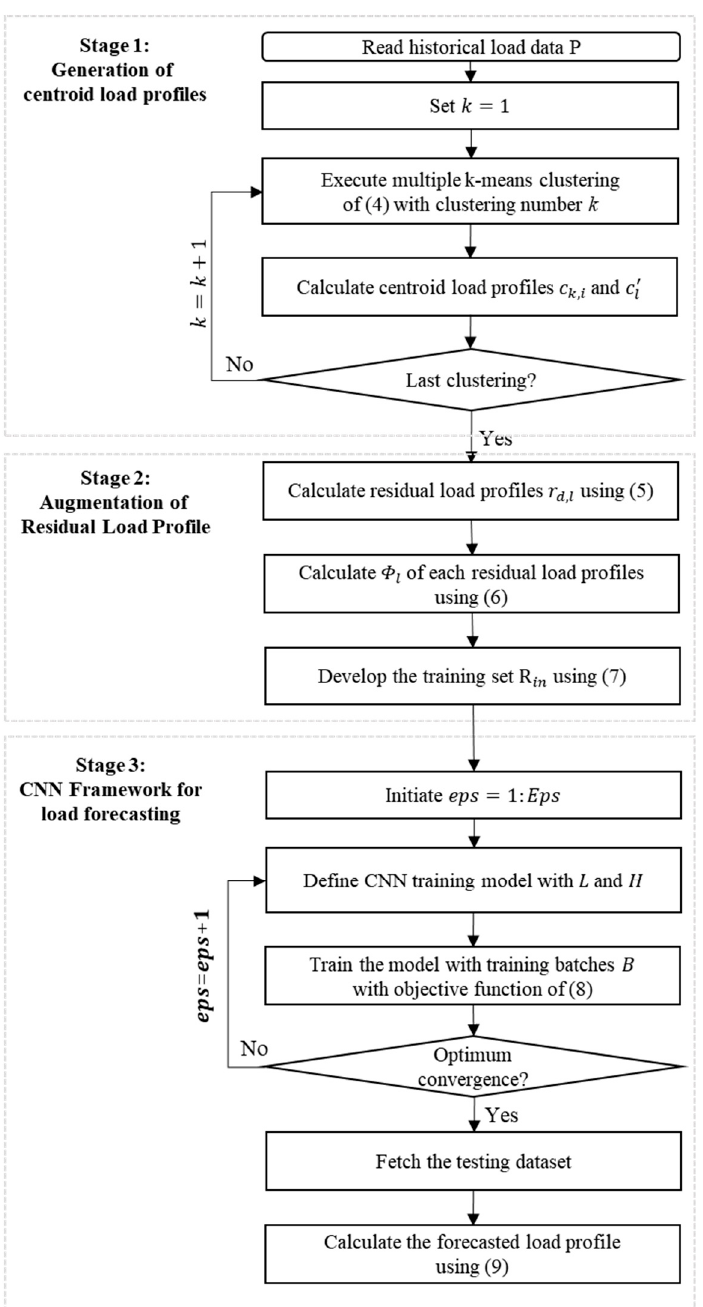
Figure 7. The overall procedure of the proposed load forecasting method for an individual household.